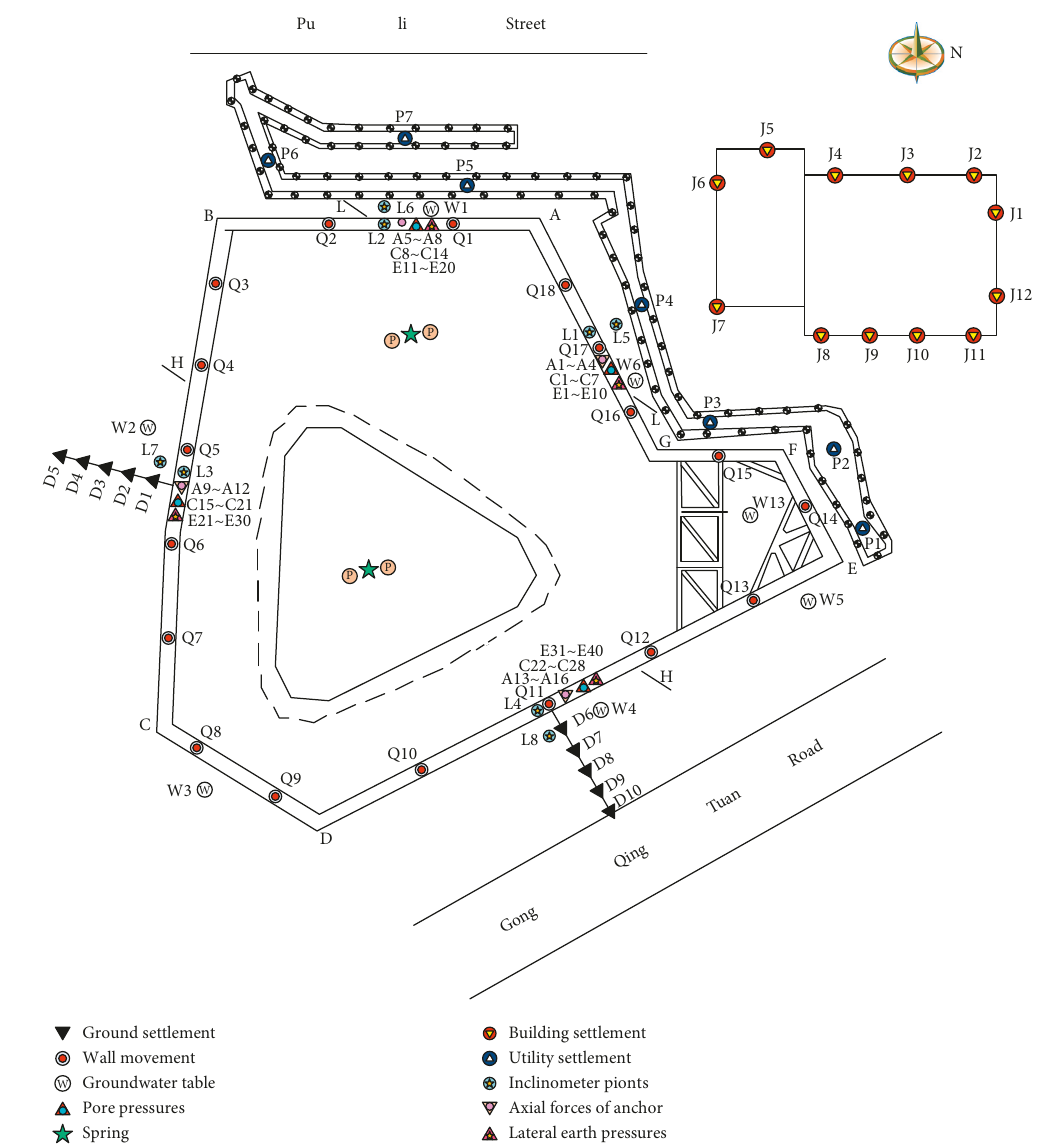
Figure 8: Layout of instrumentation